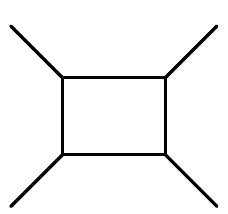
Figure 19 . Dual graph of the 5-brane web for 5d pure SU(2) gauge theory with discrete theta angle